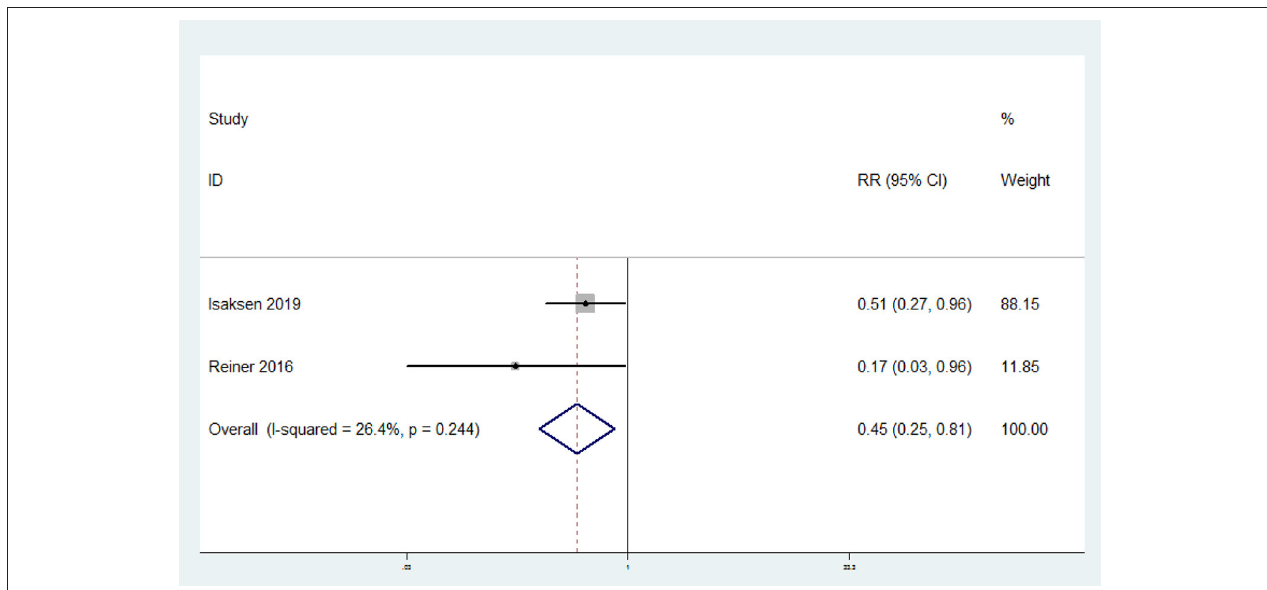
FIGURE 4 | Forest plot of meta-analysis: Overall multi-variable adjusted RR of recurrent VTE for the highest vs. lowest category of omega-3 fatty acids